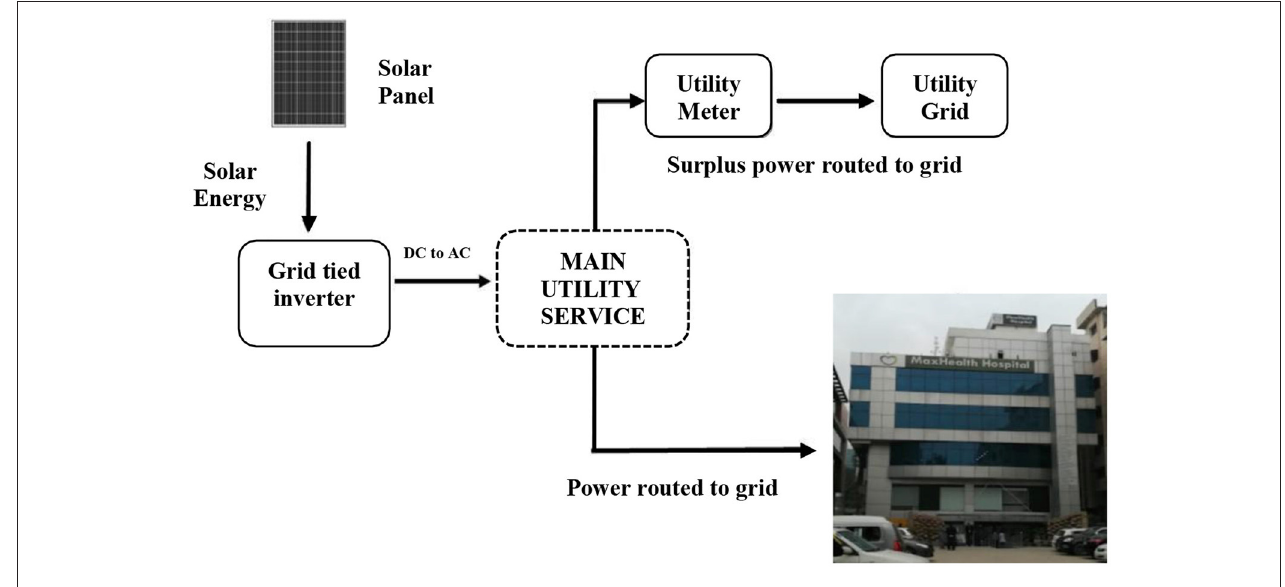
FIGURE 5 | Proposed hybrid on a grid system for a hospital.